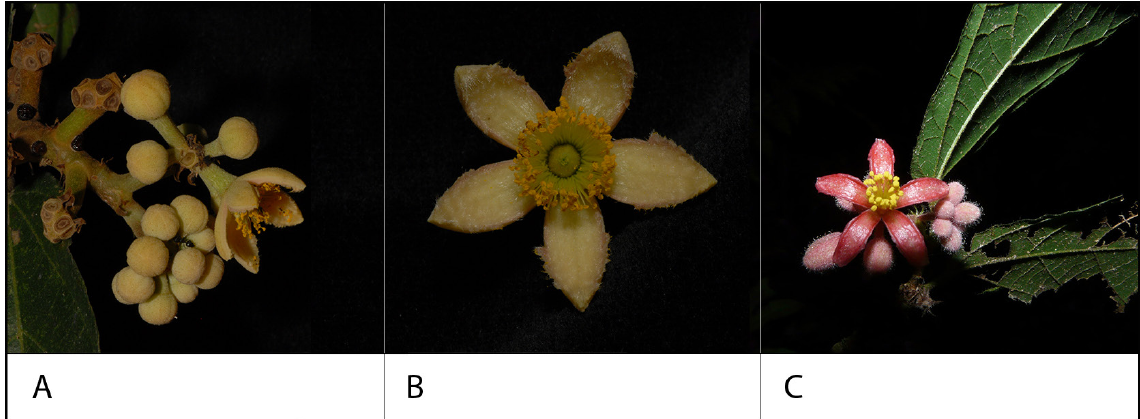
Fig. 6. Desplatsia Bocq. flower images. A – B . D. dewevrei (De Wild. & T.Durand) Burret ( Harris 9664 (E)), images by D. Harris (RBGE). C . D. subericarpa Bocq., image by Gilles